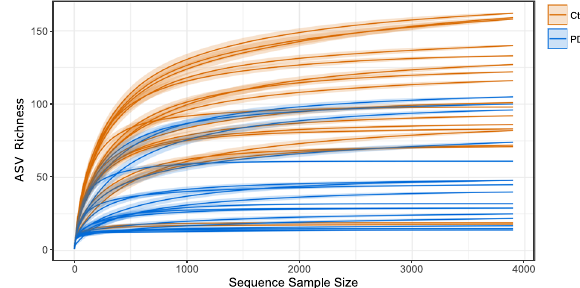
Fig. 1 Alpha rarefaction curves to visualize the dependence of eukaryotic richness and sequencing depth. Shown are amplicon sequence variation (ASV) richness rarefaction curves for the sequencing sample depth for all samples. Blue: PD samples, orange: controls. Lines represent the mean of 50 sampling steps, each, with the opaque outlines as standard errors.